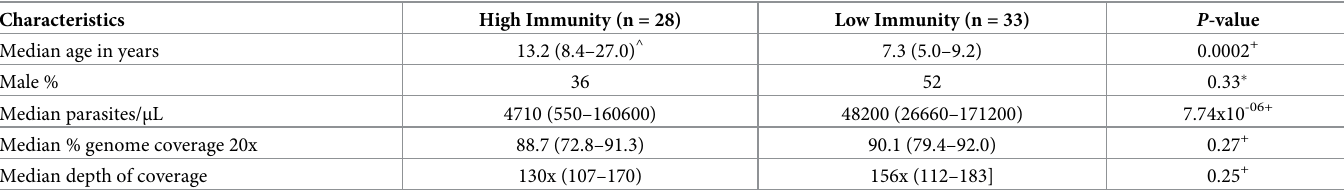
Table 1. Participant/infection characteristics in high and low immunity groups #